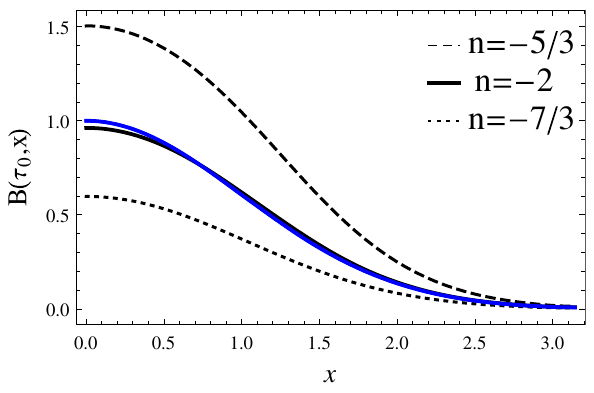
Fig. 11 Magnetic field B (τ, x ) versus x plot at τ = 1 with different values of n . The black curves correspond to coupling of Maxwell’s equationswithconservationequations(presentwork)andthebluecurve correspond to the analytical solutions